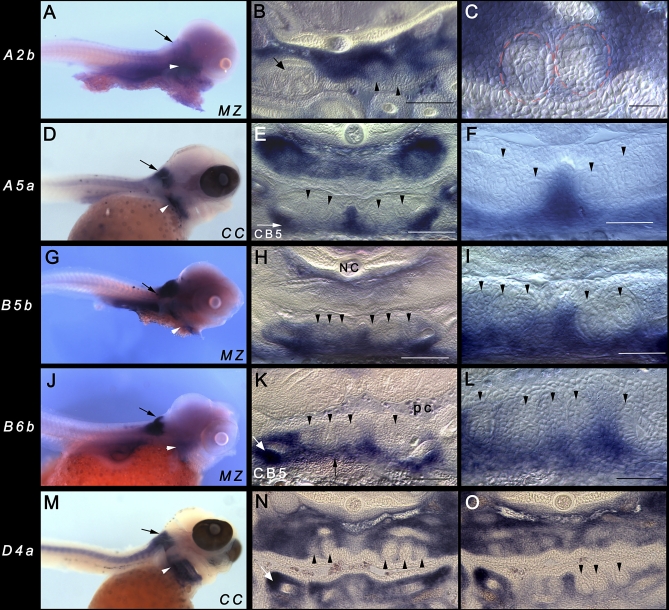
Multiple Hox Genes Are Expressed during Pharyngeal Jaw and Tooth Development in Malawi Cichlids(A–C) hoxA2b (A2b) expression in M. zebra (MZ).(D–F) hoxA5a (A5a) expression in C. conophorus (CC).(G–I) hoxB5b (B5b) expression in MZ.(J–L) hoxB6b (B6b) expression in MZ.(M–O) hoxD4a (D4a) expression in CC.(A, D, G, J, and M) show all whole-mount lateral views. (B, C, E, F, H, I, K, L, N, and O) show all coronal sections of the pharyngeal jaw (PA7/CB5).(A) hoxA2b is expressed in the hindbrain (black arrow) and the pharyngeal arch mesenchyme (white arrowhead).(B and C) show an oblique coronal section: (B) hoxA2b expression surrounds more mature upper pharyngeal dentition away from cells directly associated with the teeth (black arrow). Tooth germs at an earlier stage of development show the expression of hoxA2b in closer proximity within the mesenchymal cells enveloping the tooth germs (black arrowheads) and in (C) demarcated by red dashed circles.(D) hoxA5a is expressed in the hindbrain (black arrow) and in the posterior pharyngeal mesenchyme (white arrowhead).(E and F) show a coronal section: (E) hoxA5a expression underlying the teeth (black arrowheads) in the pharyngeal jaw (and in [F]). hoxA5a expression is present around the forming cartilages of the fifth ceratobranchial (CB5), (white arrow) and the upper fourth epi/pharyngobranchial.(G) hoxB5b is expressed in the hindbrain (black arrow) and the most posterior pharyngeal arch mesenchyme (white arrowhead).(H and I) show a coronal section: (H) hoxB5b marks the dental mesenchyme surrounding each tooth germ (black arrowheads) in the pharyngeal jaw (CB5); higher magnification is shown in (I). NC, notochord.(J) hoxB6b is present in the developing hindbrain (black arrow) and the posterior pharyngeal mesenchyme (white arrowhead).(K and L) show a coronal section: (K) hoxB6b expression surrounds each tooth in the dental mesenchymal cells (black arrowheads); stronger expression is observed at the base of each tooth unit (black arrow), possibly related to the attachment between the mineralized tooth and the underlying cartilage of CB5. Expression surrounds the pharyngeal cartilages (white arrow); a higher magnification is shown in (L). pc, pharyngeal cavity.(M) hoxD4a is expressed in the hindbrain (black arrow) and in the posterior pharyngeal mesenchyme (white arrowhead).(N and O) show a coronal section: (N) hoxD4a is strongly expressed in the dental mesenchyme surrounding each tooth germ of the pharyngeal jaw. Each individual tooth is demarcated by the mesenchymal expression (black arrowheads). hoxD4a is also strongly up-regulated in the mesenchyme directly enveloping the cartilages of CB5 (white arrow). Expression of hoxD4a is identical between the upper (N) and lower (O) pharyngeal dentition.(B, E, H, K, N, and O) are all to the same scale: scale bars represent 100 μm. Scale bar in (C) represents 20 μm. Scale bars in (F, I, and L) represent 50 μm. Embryos shown are 6–7 dpf.